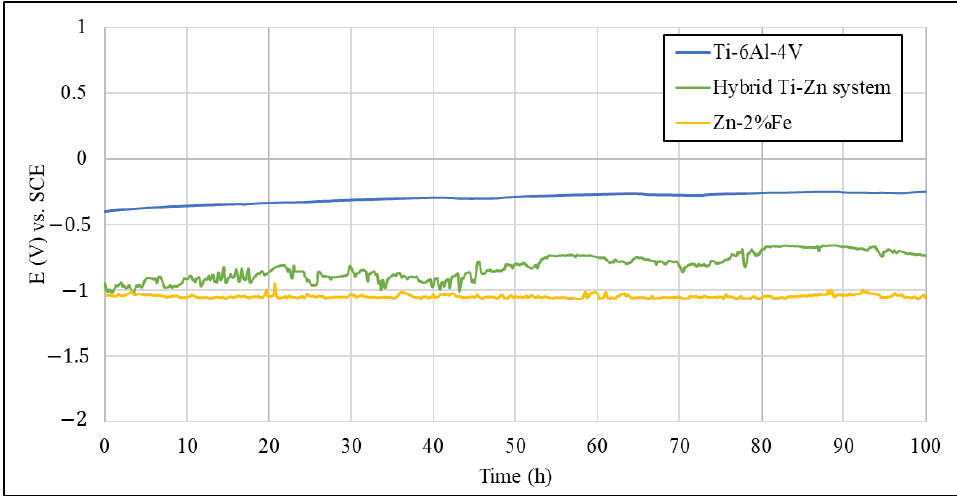
Figure 5. Cyclic potentiodynamic polarization analysis in PBS solution ( a ) hybrid Ti-Zn system ( b ) Zn-2%Fe alloy.